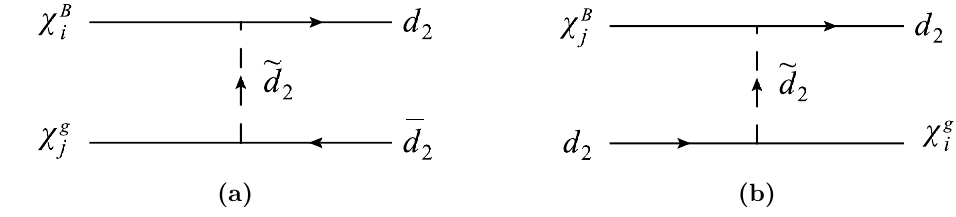
Figure 22. (a) Example of diagram contributing to bino-gluino annihilation to d 2 d 2 . (b) Example of diagram contributing to bino conversion to gluino via scattering o(cid:11)